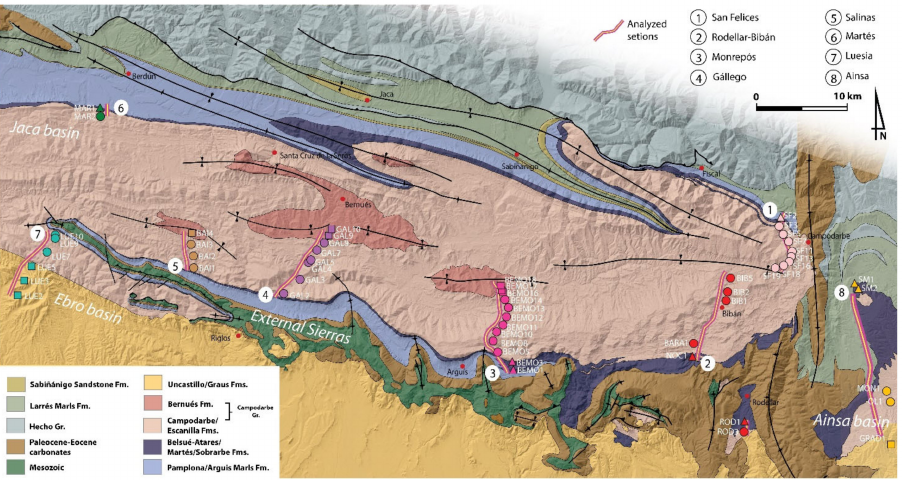
Figure 3. Geological map of the of the Jaca basin (modified from Puigdef à bregas [23]). Yellow-purple lines show the location of the analyzed sections. Numbers refer to each section: (1) San Felices section, (2) Rodellar-Bib á n section, (3) Monrep ó s section, (4) G á llego section, (5) Salinas section, (6) Mart é s section, (7) Luesia section, and (8) Ainsa section. Numbers and symbols refer to each of the analyzed samples for sandstone petrography